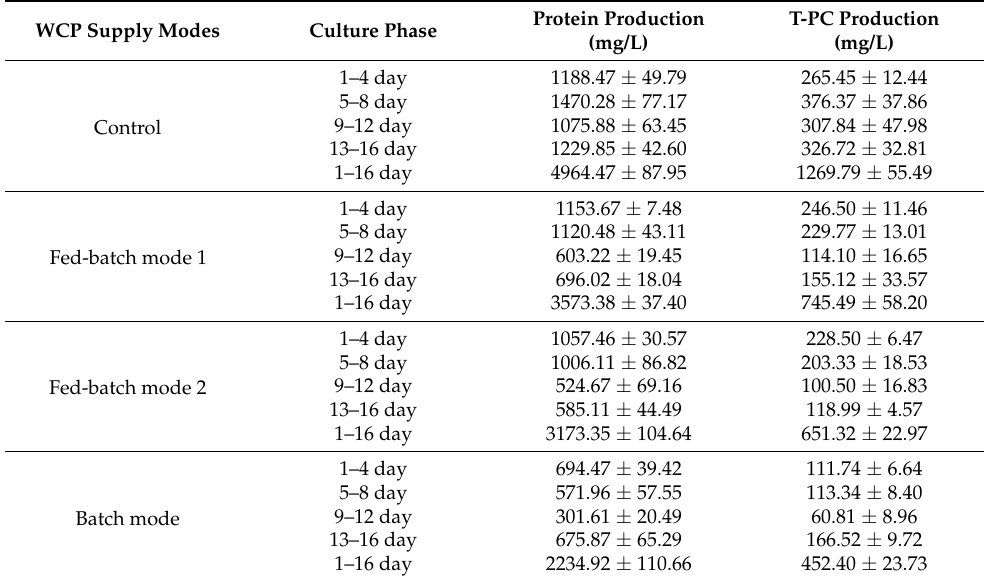
Table 5. Effects of the caprolactam wastewater supply mode on protein and total PC production (mean ± standard deviation) of Arthrospira platensis